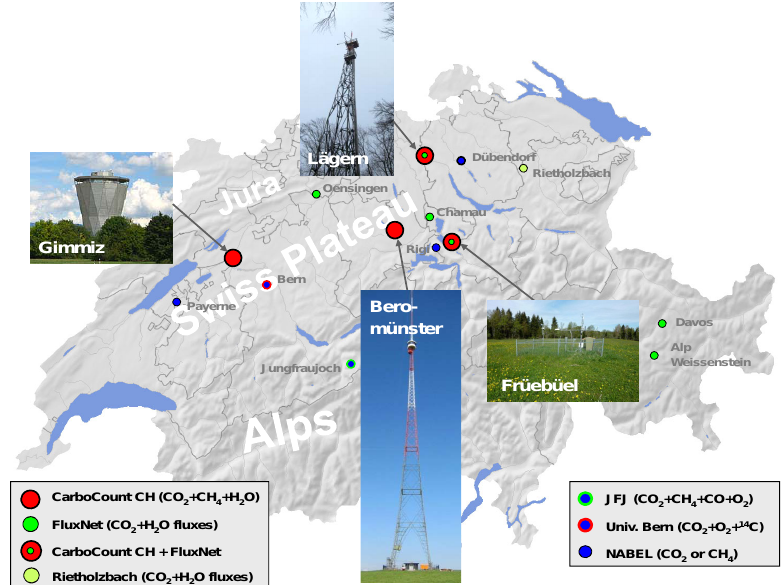
Figure 1. An overview of CarboCount CH measurement site locations within Switzerland: Beromünster (BEO), Früebüel (FRU), Gimmiz (GIM), and Lägern-Hochwacht (LAE). The sites are concentrated along the Swiss Plateau. The measurement heights and locations are listed in Table 1. Also shown are other sites with greenhouse gas concentration or flux measurements that complement the network. These include the sites of the Swiss FluxNet, the high Alpine research station Jungfraujoch, and sites of the Swiss air pollution monitoring network NABEL (National Air Pollution Monitoring